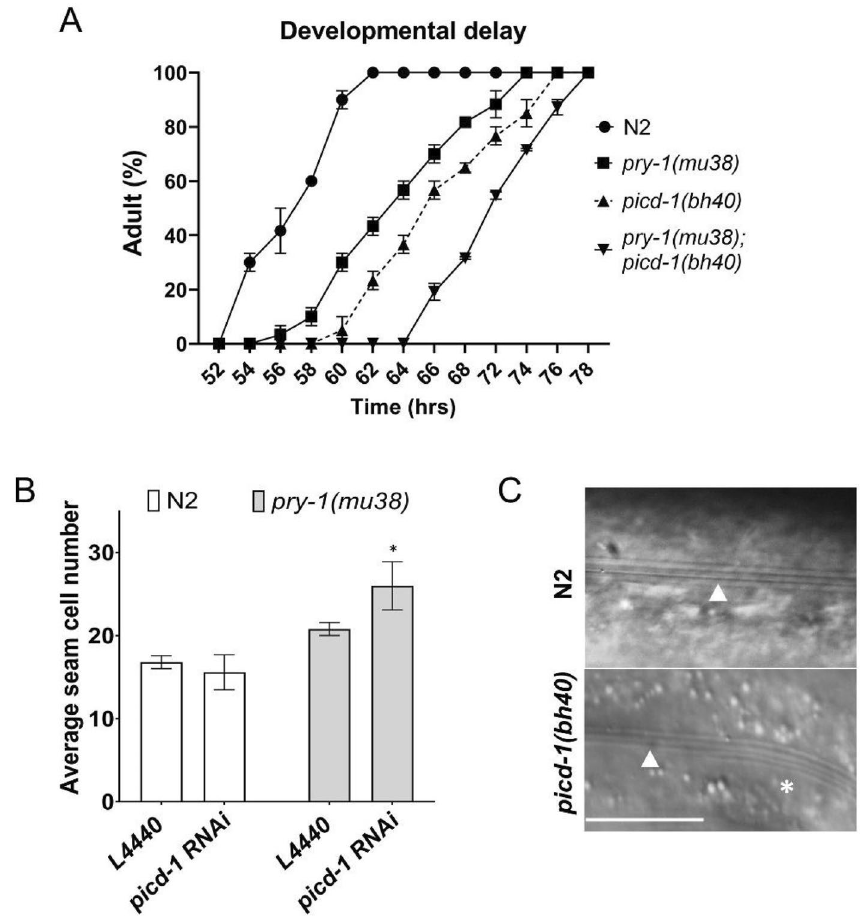
Figure 5. picd-1 regulates developmental timing, seam cell division and alae formation. ( A ) picd-1 mutants exacerbate the developmental delay of pry-1 mutants. The data shows the average time taken by picd-1(bh40), pry-1(mu38) and pry-1(mu38); picd-1(bh40) double mutants to reach adulthood compared to wild-type animals. The number of animals for two replicates are: n = 60 for N2, pry-1(mu38), and picd-1(bh40) ; and 95 for pry- 1(mu38); picd-1(bh40) ) The error bars represent the standard deviation. ( B ) Bar graph showing the average number of seam cells (two replicates, n = 30) in the wild-type and pry-1(mu38) animals following control (L4440) and picd-1 RNAi. The error bars represent the standard deviation. ( C ) Representative images showing alae (white arrowheads) in wild-type N2 and picd-1(bh40) animals. Normal alae are marked with an arrowhead and an extra alae in the picd-1 mutant is indicated by a star (*) (41.88 ± 0.22%, n = 43, p < 0.0001). Statistical analyses were done using multiple unpaired t-test and recorded in Table S2. In panel B, star (*) indicates p < 0.05. Scale bar in panel ( C ) is 25